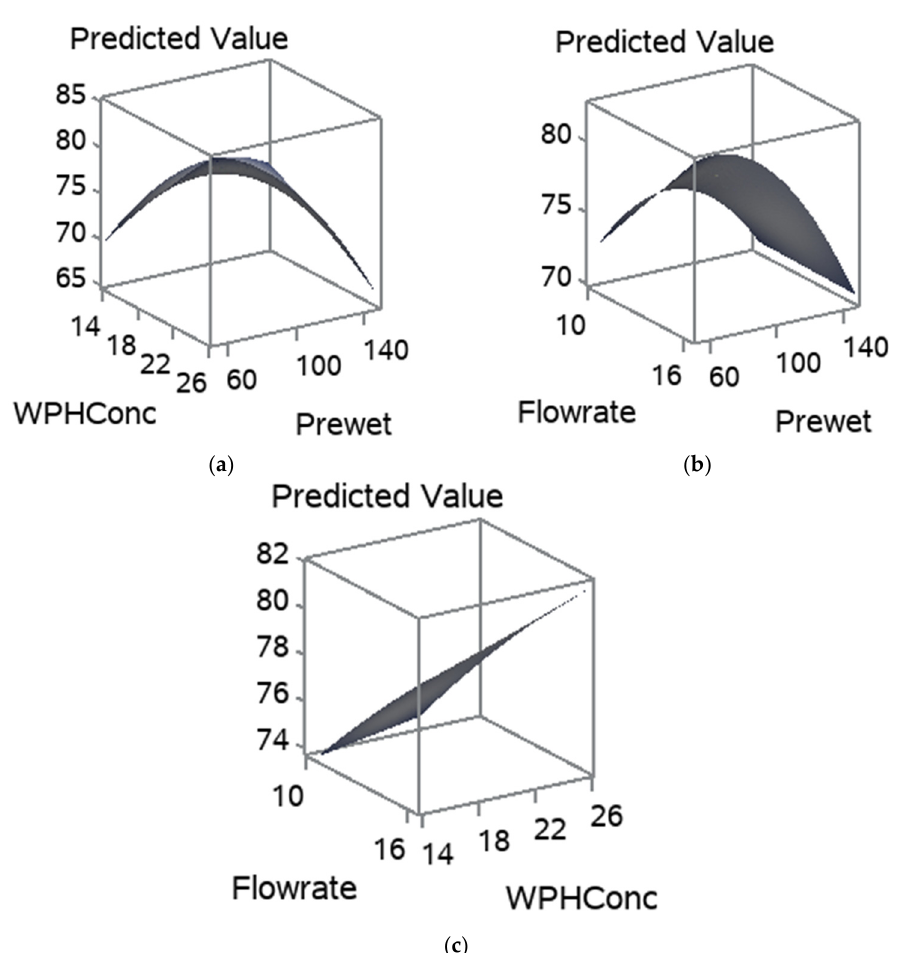
Figure 6. Response surfaces for RDI, for ( a ) pre-wet mass vs. WPH concentration; ( b ) flow rate and pre-wet mass; and ( c ) WPH concentration and flow rate .